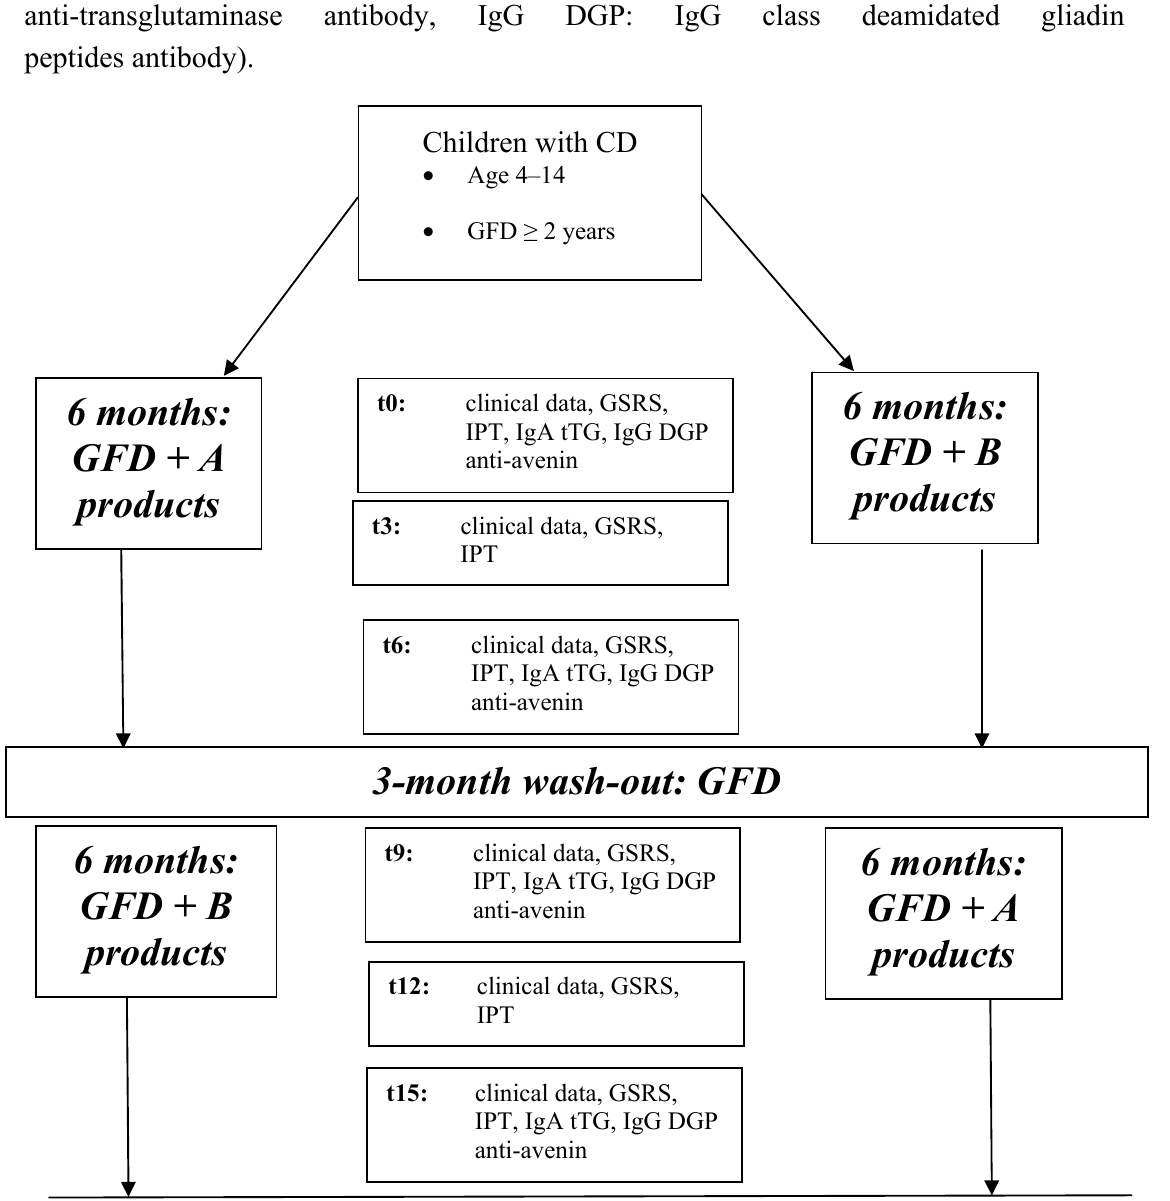
Figure 1. Flow-chart of the multicenter trial (t0: baseline, t3: 3-month follow-up, t6: 6-month follow-up, t9: 9-month follow-up, t12: 12-month follow-up, t15: